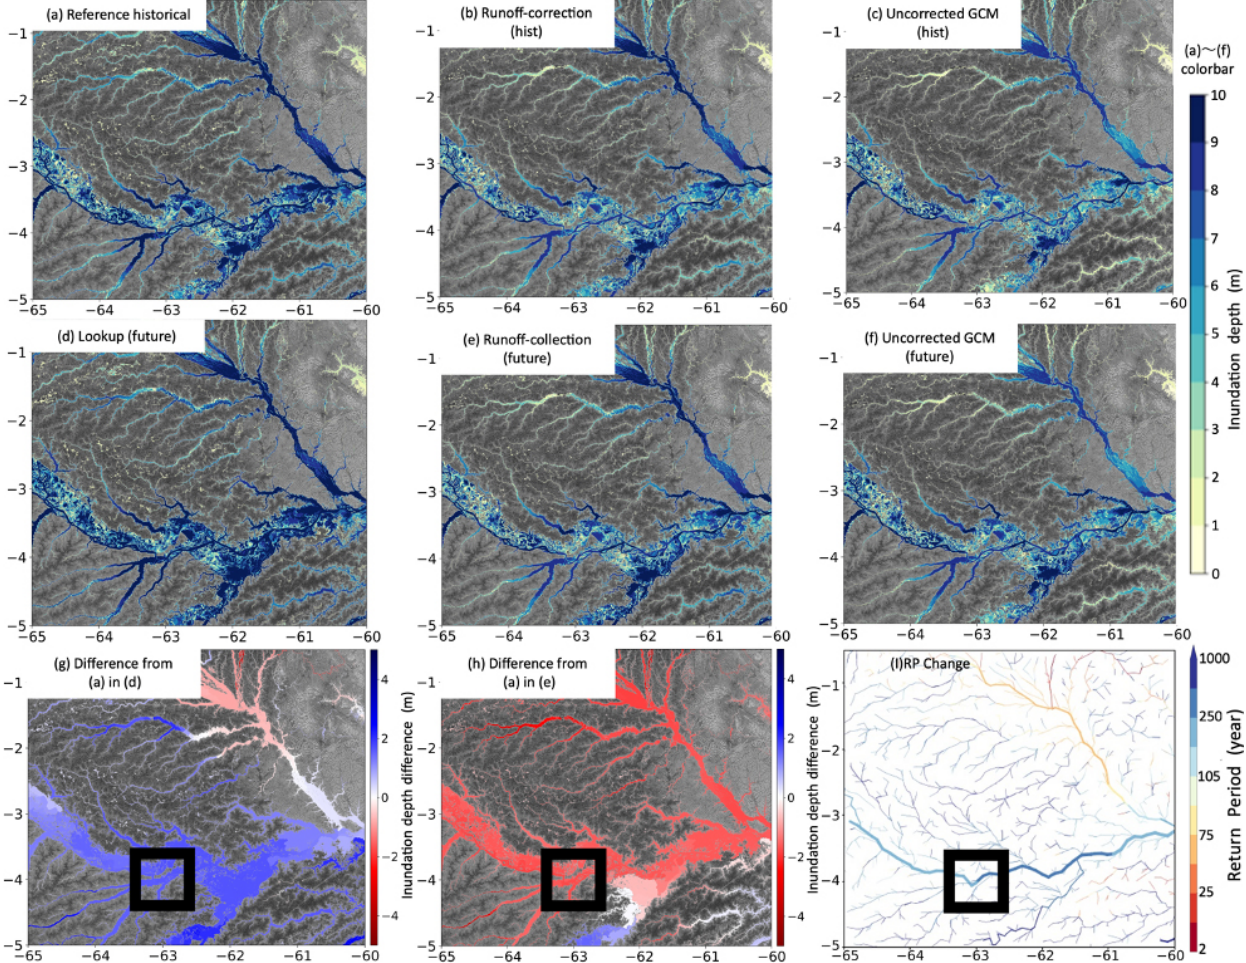
Figure 4. 100-year RP hazard map in the Amazon River basin (using IPSL-CM6A-LR of the CMIP6 GCM). (a) Reference historical- hazard map (based on reanalysis data), (b) hazard map constructed using the runoff-correction method (historical), (c) hazard map based on uncorrected GCM runoff (historical), (d) hazard map constructed using the lookup method, (e) hazard map constructed using the runoff- correction method (future) and (f) hazard map based on uncorrected GCM runoff (future). (g, h) Differences from the reference historical- hazard map in (g) the hazard map obtained with the lookup method and (h) the hazard map obtained using the runoff-correction method (future) and (i) the historical RP of river water level corresponding to the 100-year RP in the future. Black boxes in panels (g) and (h) indicate the location of the GRDC Itapeua station (63.0278 ◦ W, 4.0578 ◦